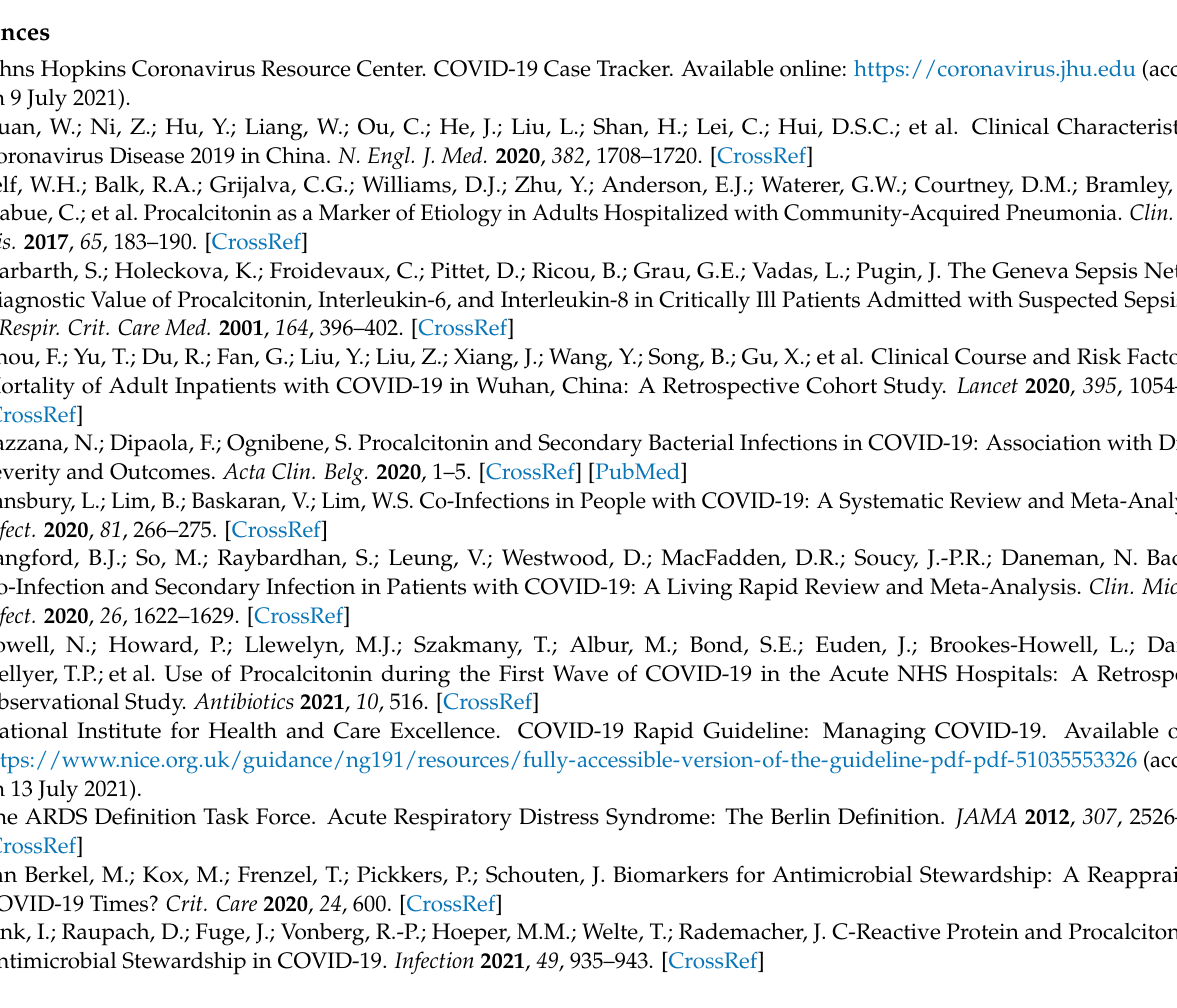
Figure S2: CRP trajectories over time for individual patients (in mg/L), Figure S3: WBC trajectories over time for individual patients (in 1000/L), Figure S4: Violin plots for days of LCBI and VAP/VAT onset and first biomarker